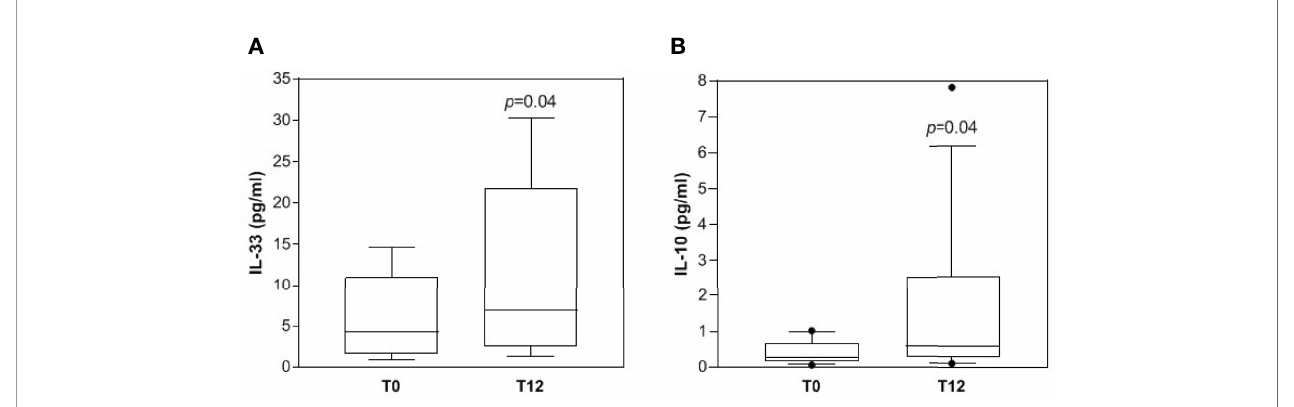
FIGURE 1 | Changes of serum cytokines following homotaurine supplementation. IL-33 ( A , n=5) and IL-10 levels ( B , n=14) were measured as described in patients ’ serum at baseline (T0) and after 12-month homotaurine treatment (T12). Distribution of data and median values are reported in each box plot.